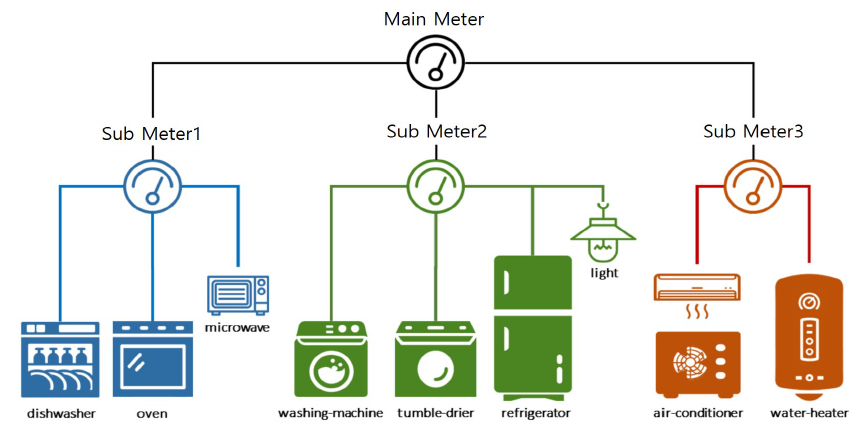
Figure 1. A Non-Intrusive Load Monitoring (NILM) system [18]. Reprinted from ref.